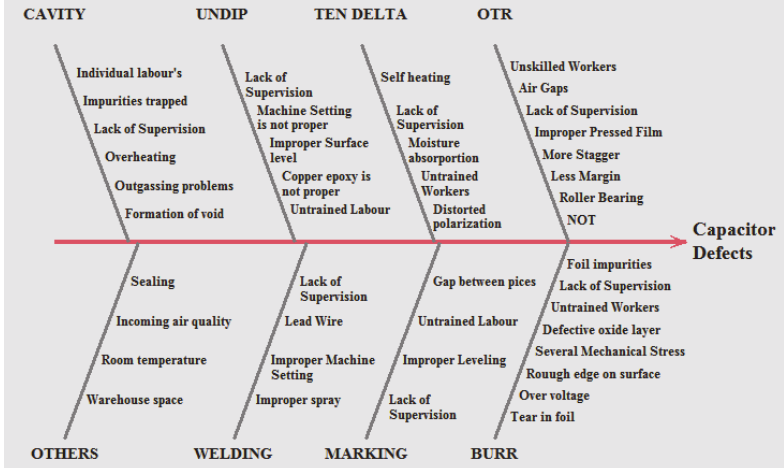
Fig. 2. Cause and Effect Diagram